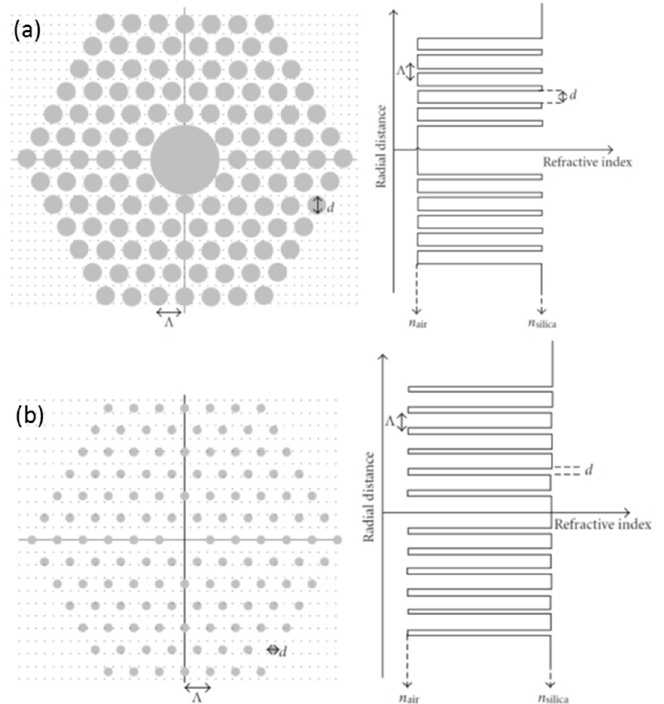
Figure 2. ( a ) Illustration of hollow core (HC)-photonic crystal fibers (PCF) cross-section and respective refractive index profile; ( b ) an illustration of solid core (SC)-PCF cross-section and its refractive index profile. The colors are grey for air and white for silica. Reprinted with permission from [34].